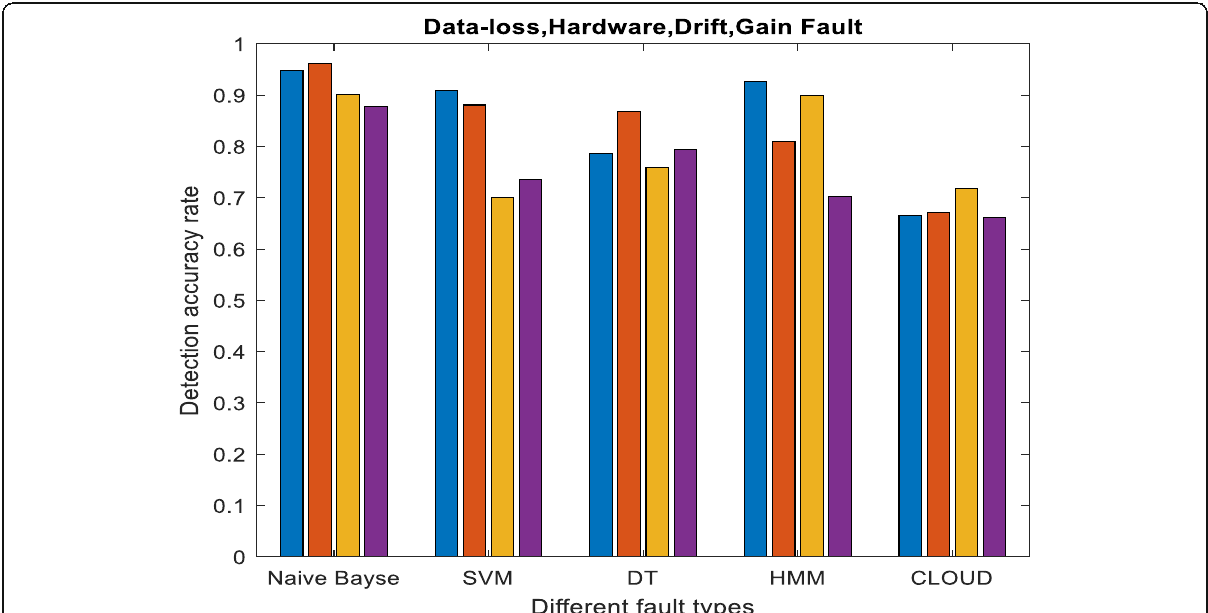
Fig. 11 Comparison of the proposed scheme for the classification of a collecting dataset of WSN with the SVM, DT, HMM, and CLOUD methods for different faulty, e.g., data loss, hardware, drift, and gain fault according to the DA